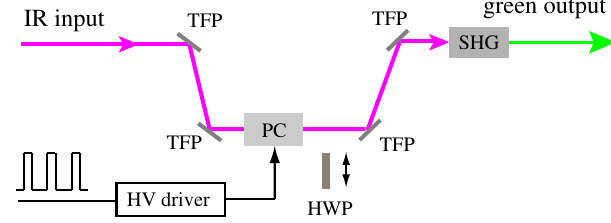
FIG. 11. PC, TFP, and SHG are combined to achieve high extinction ratio pulse picker. PC, Pockel ’ s cell; TFP, thin film polarizer; HWP, half-wave plate; SHG, second harmonic generation.